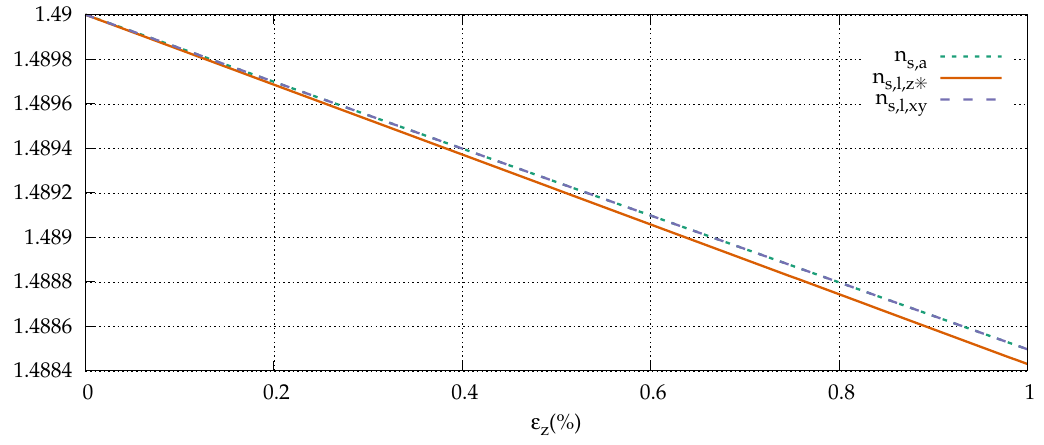
Figure 4. Strain-dependent refractive indices of the core of the